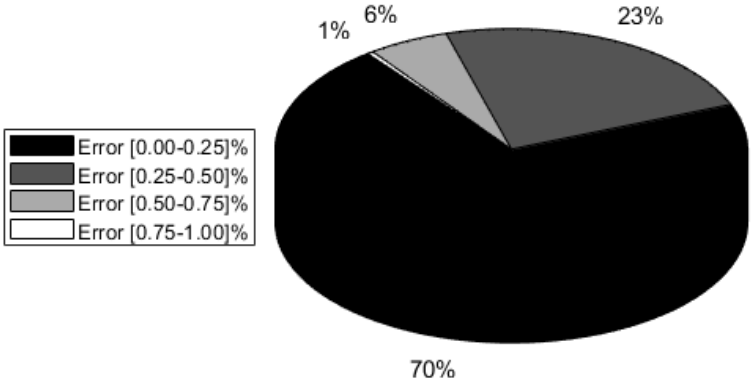
Figure 10. Error distribution in % of forecaster 4 (period January–August 2018).